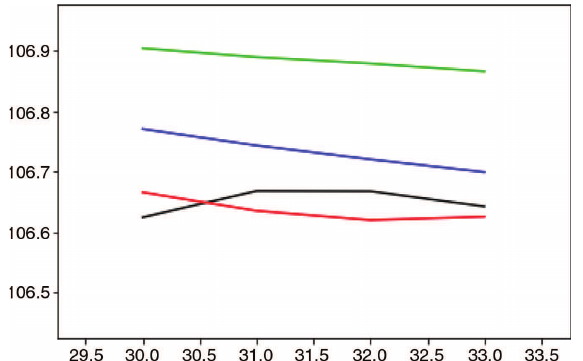
Figure 9: Image Data with Price and Moving Average Lines Without Resizing.